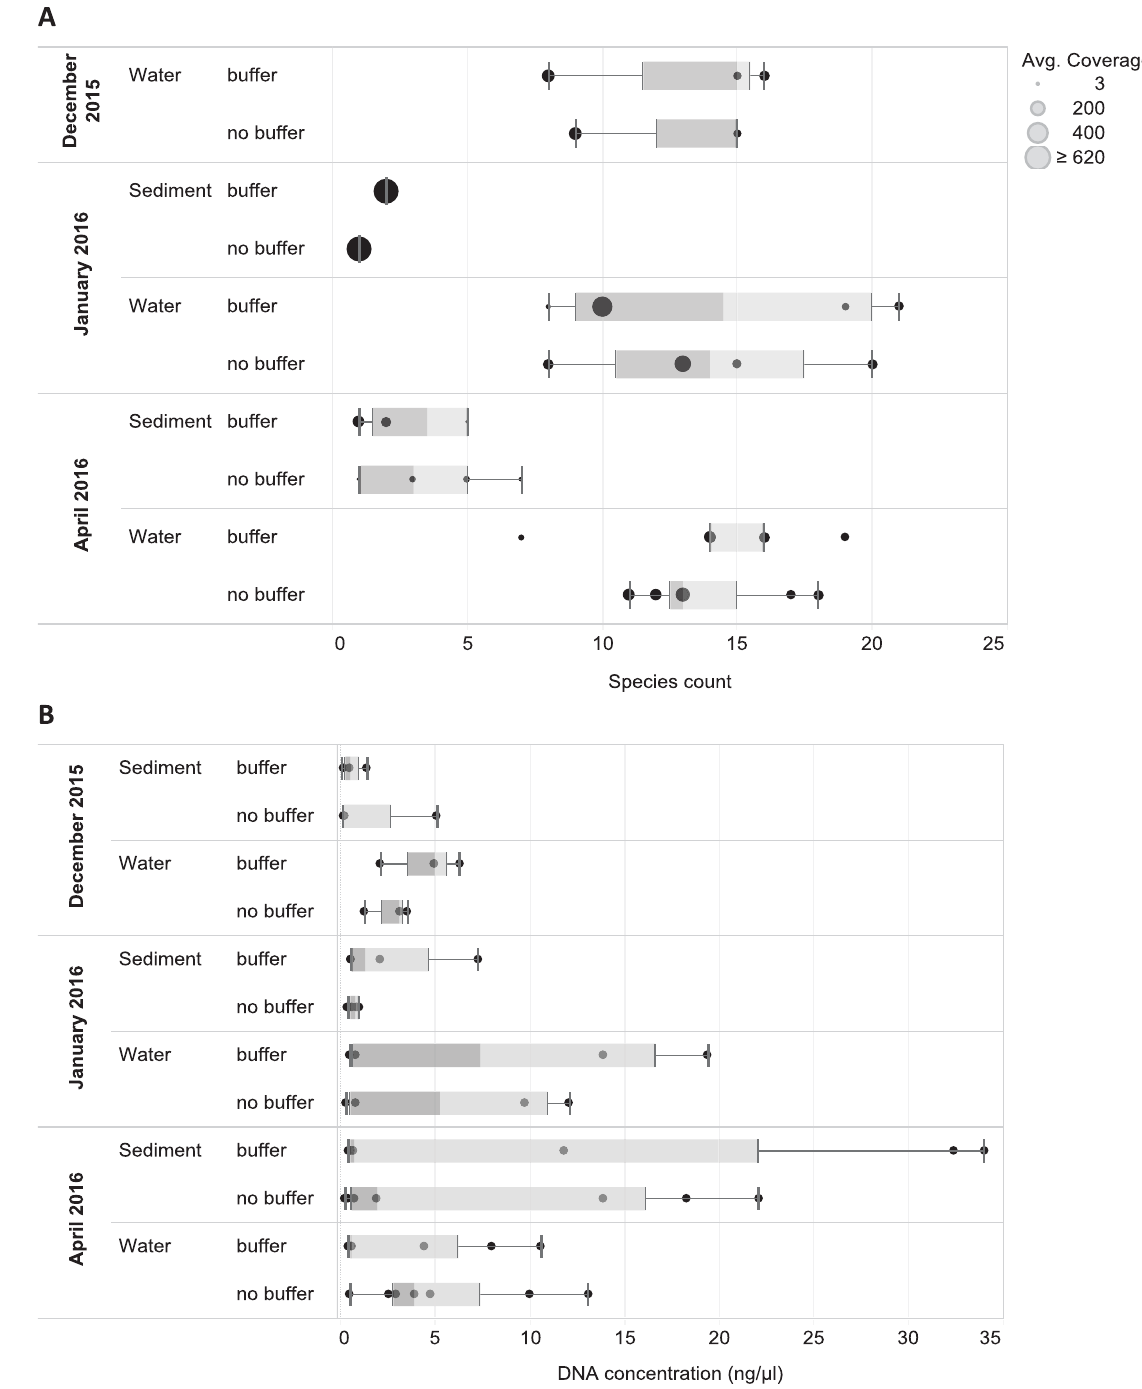
PLOS ONE | https://doi.org/10.1371/journal.pone.0215505 April 22, 2019 12 /